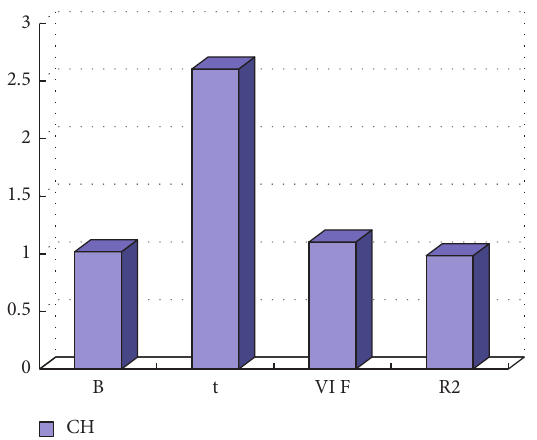
Figure 6: The regression model of Haitian background for